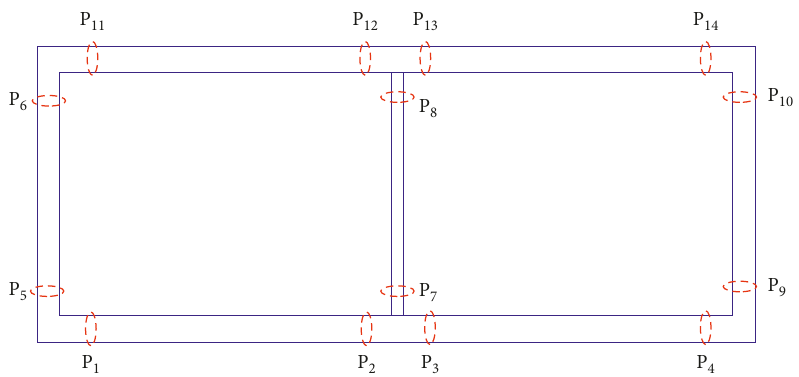
Figure 12: Schematic diagram of key parts of dynamic force of the subway station structure.